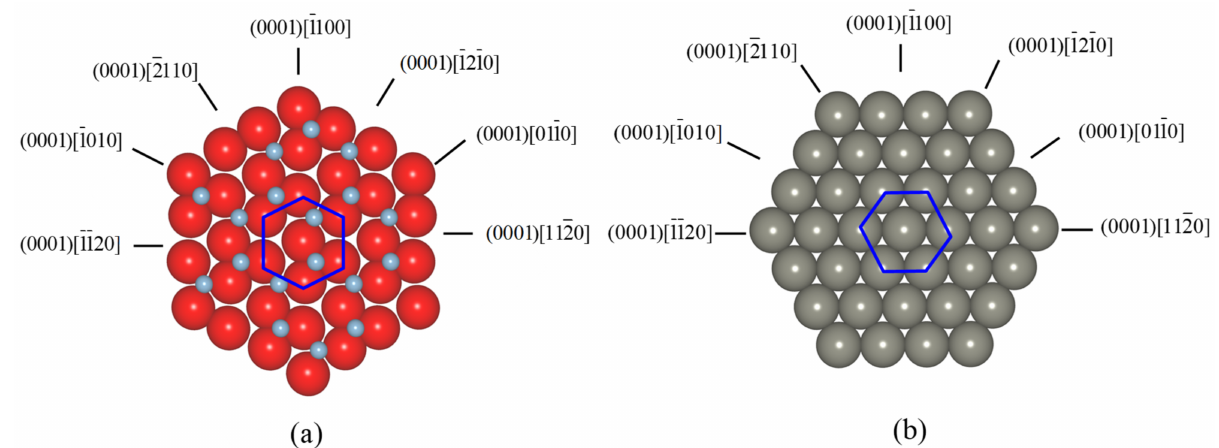
Figure 2. Top view of basal slip or twinning directions of ( a ) sapphire and ( b )